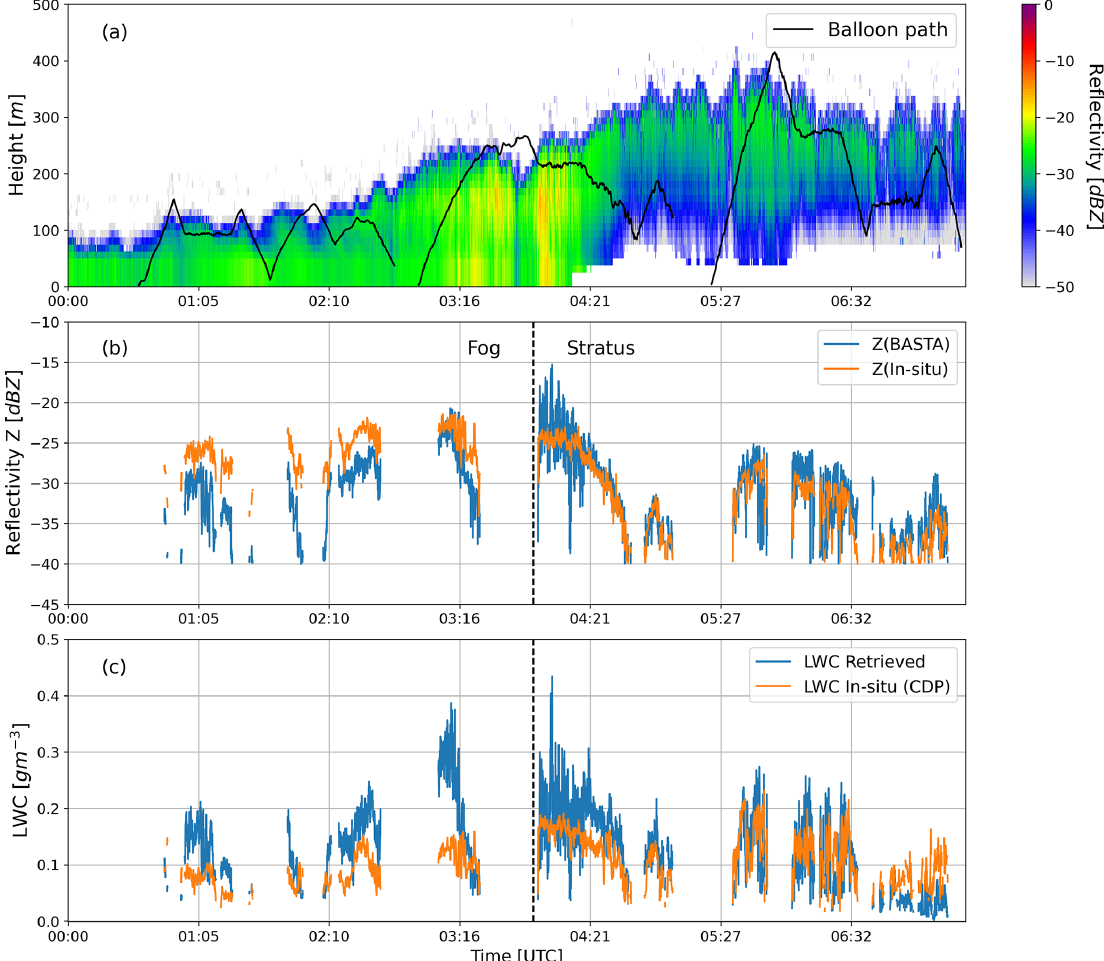
Figure 7. (a) Radar reflectivity and balloon path, (b) comparison of radar reflectivity with reflectivity calculated from CDP using DSD, (c) comparison of retrieved LWC with in situ